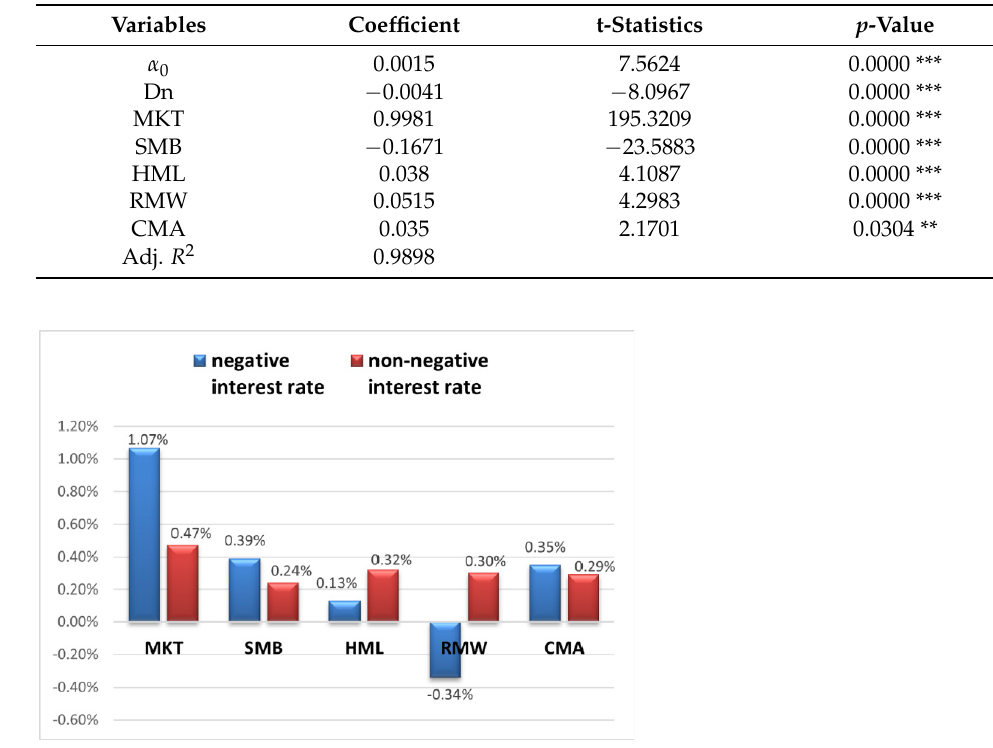
Table 7. Five-factor adjusted stock returns in negative real interest rate cycle. The table reports five-factor adjusted returns of the S&P 500 in negative real interest rate cycle. The long-term negative real interest rates are extracted and calculated from Shiller Online Data. In Equation (9), if the dummy variable Dn equals 1, indicates negative real interest rate cycle, and 0 otherwise. All t-statistics are based on the Heteroskedasticity-Autocorrelation-Consistent standard errors. **, and *** denote significance at the 5%, and 1% levels, respectively.